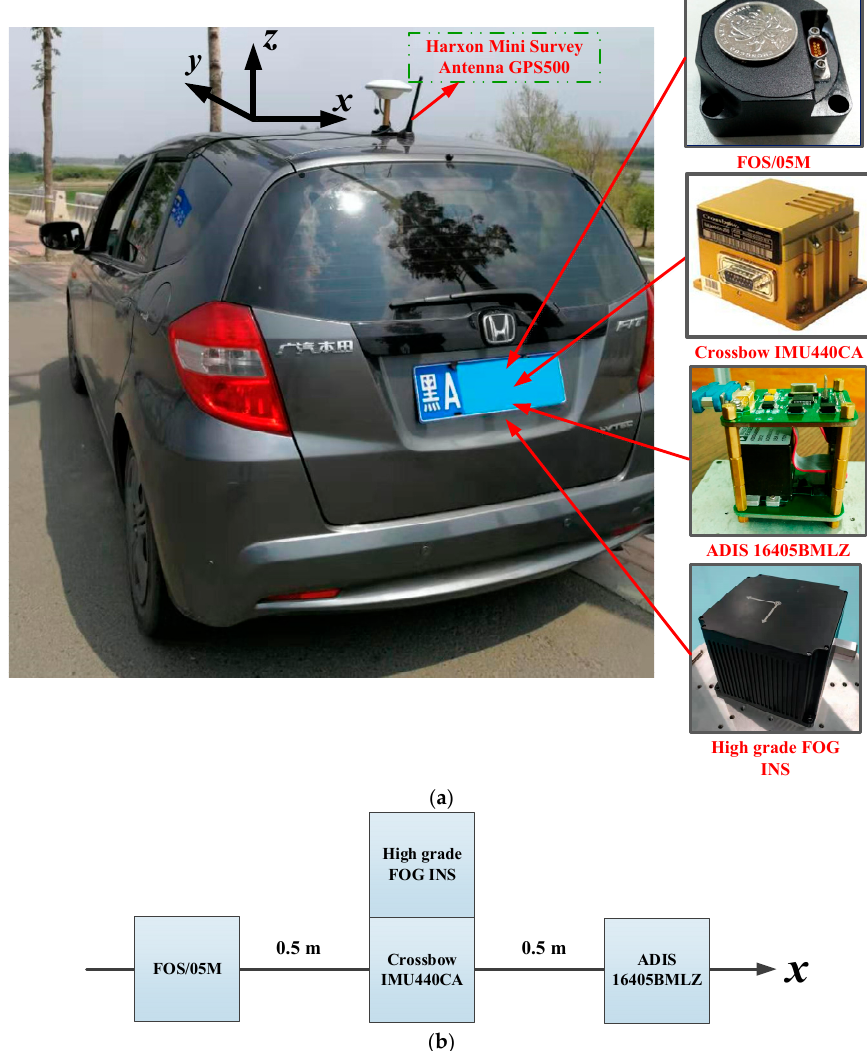
Figure 4. The equipment installation diagram for the road test. ( a ) The test vehicle and sensors; ( b ) internal installation diagram.